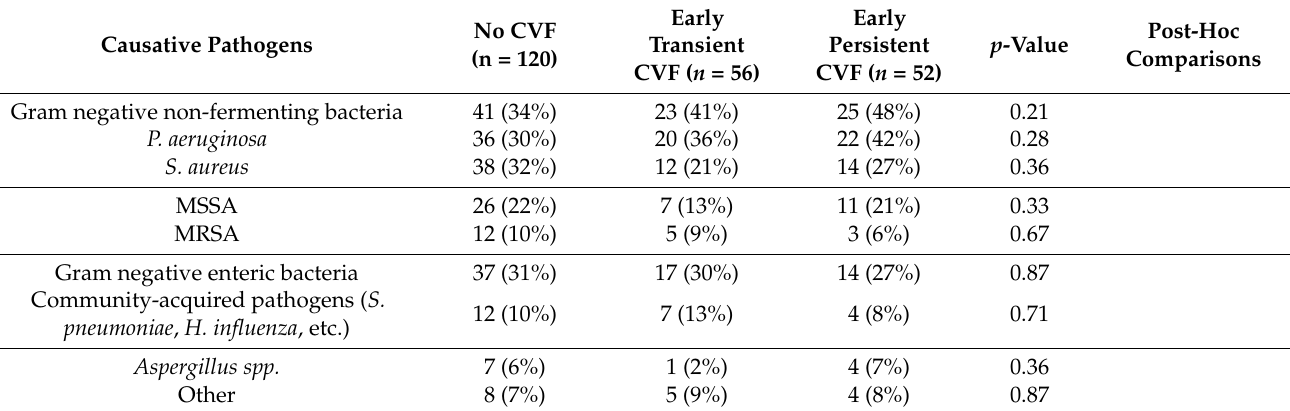
Table 6. Causative